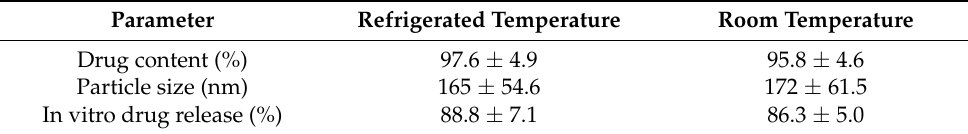
Table 9. Stability data of optimized solid lipid nanoparticle batch (CL10) after 3